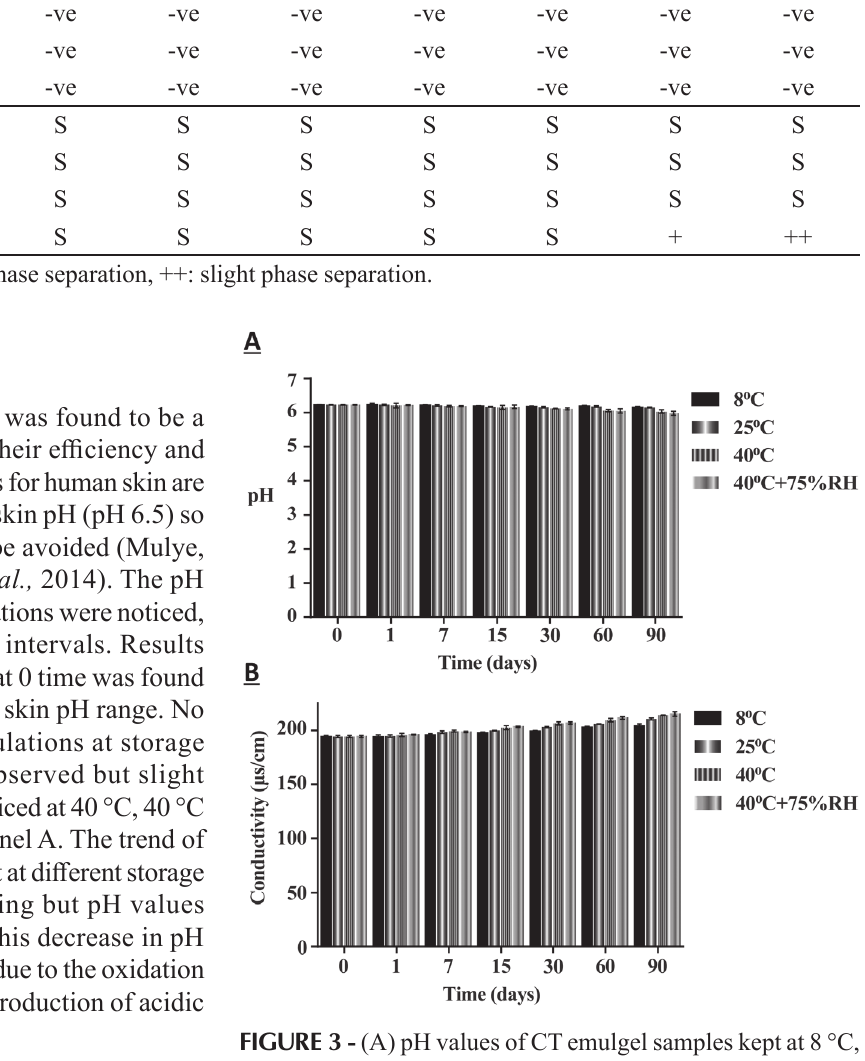
TABLE II - Organoleptic characteristics of CT emulgel samples placed at different storage conditions Organoleptic